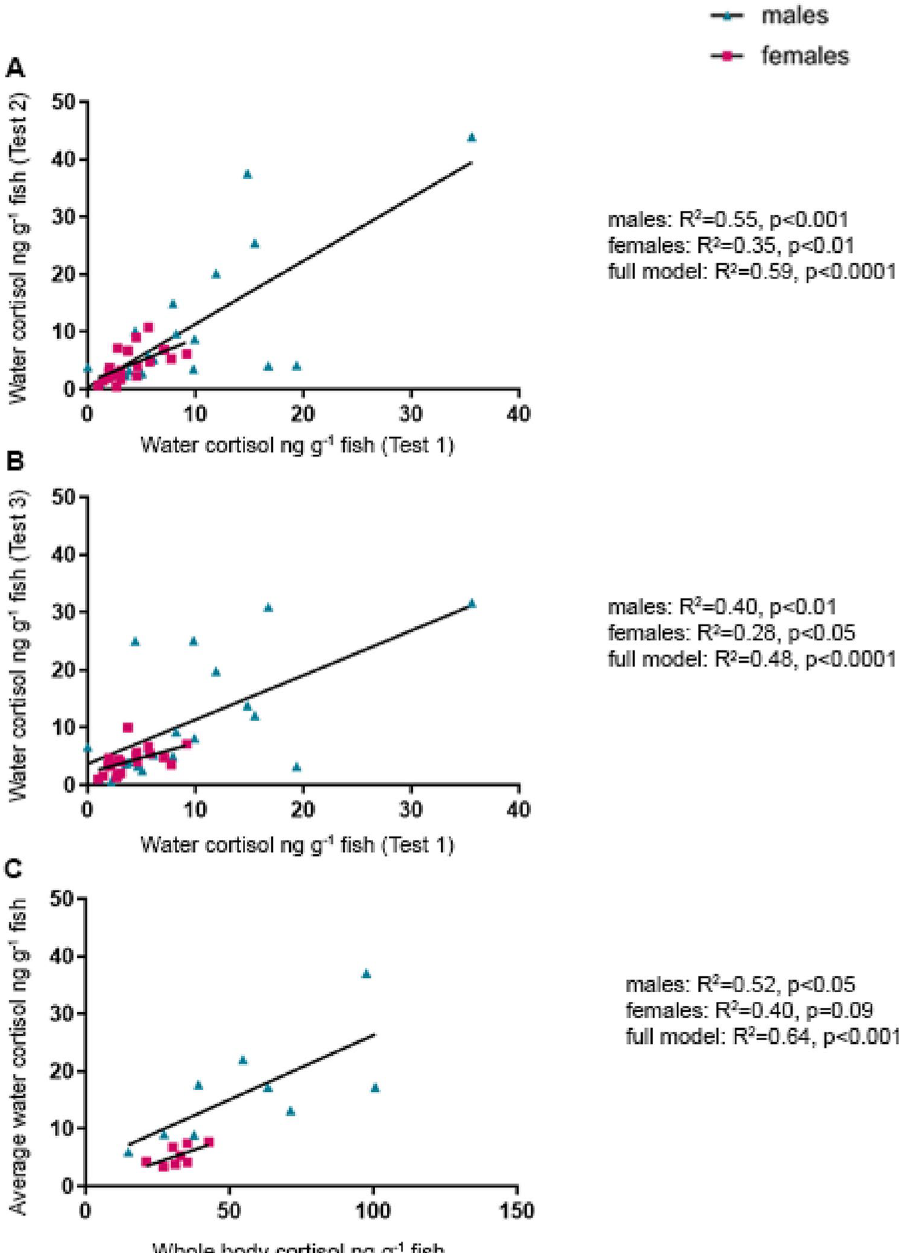
Figure 2. Cortisol-response to stress is variable between, but consistent within individual zebrafish ( Danio rerio ). Consistency and validity of post-stress water cortisol levels following acute stress was assessed by comparing water-borne cortisol levels following three consecutive stress tests ( A , B ) and mean water cortisol levels to whole body cortisol following a fourth stress test ( C ) in males (blue triangles) and females (pink squares). Consistency in cortisol responsiveness was tested by linear regression and correlation by a Pearson r test in case of a normal distribution and by a Spearman rank test in case of a non-normal